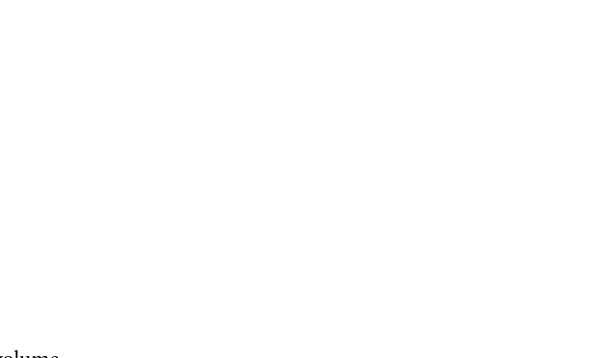
Table 6. The range analysis of total pore